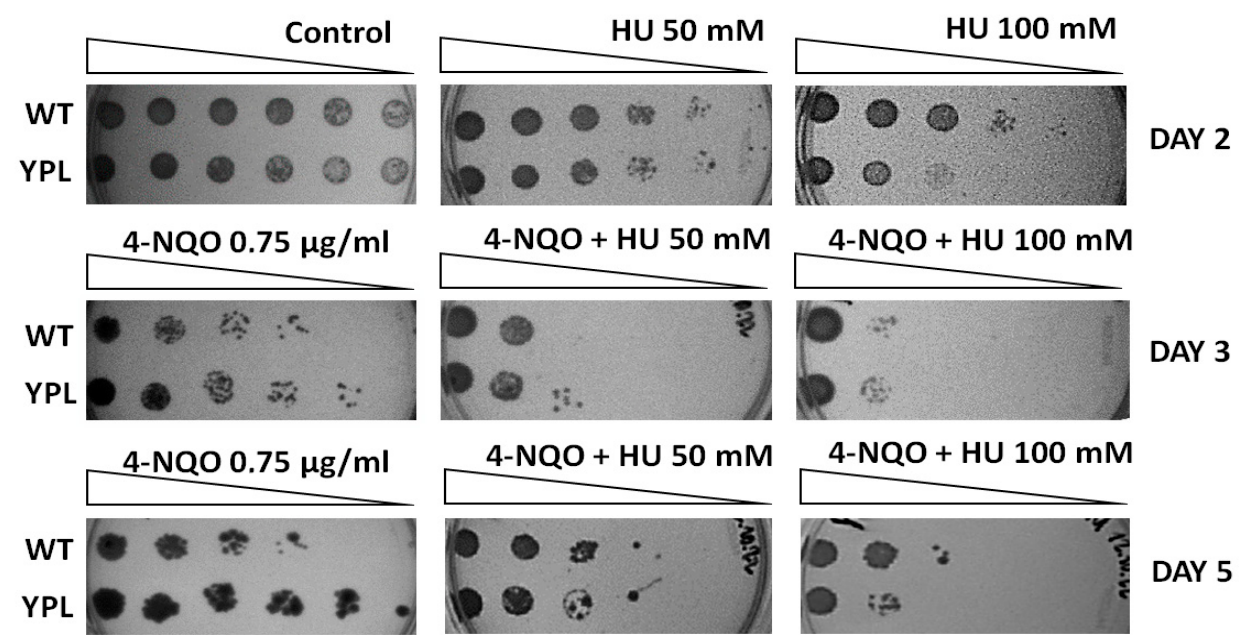
Figure 5. HU inhibits YPL strain growth and reverses its hyper-resistance to 4-NQO. The YPD agar plates with or without (control) additives (HU and/or 4-NQO) were incubated for 5 days at 30 °C.